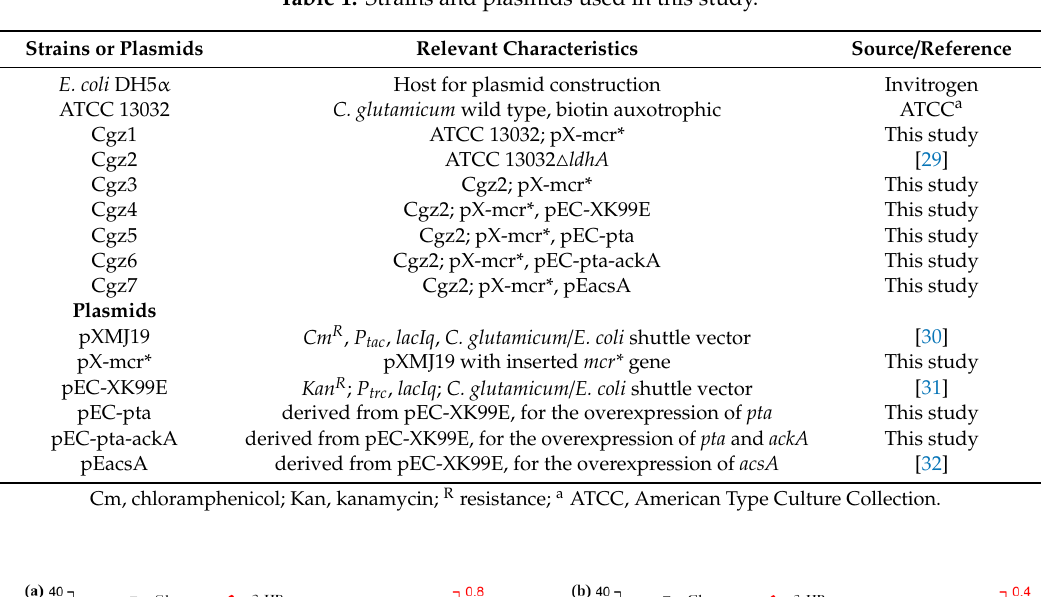
Table 1. Strains and plasmids used in this study. Strains or